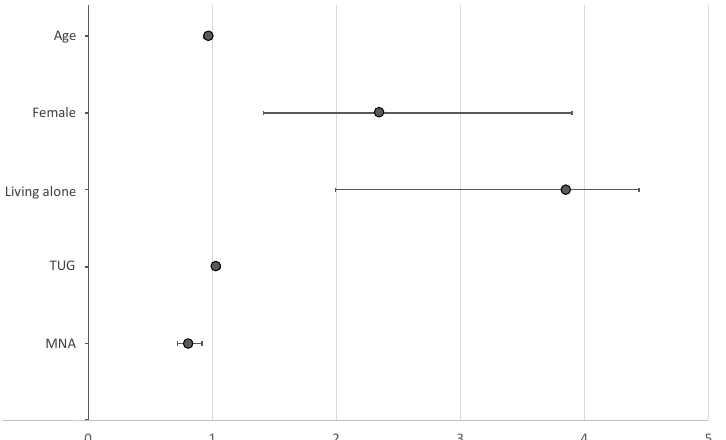
Figure 1. Predictors of major depressive disorder (odds ratio [OR] and 95% confidence interval [CI]).